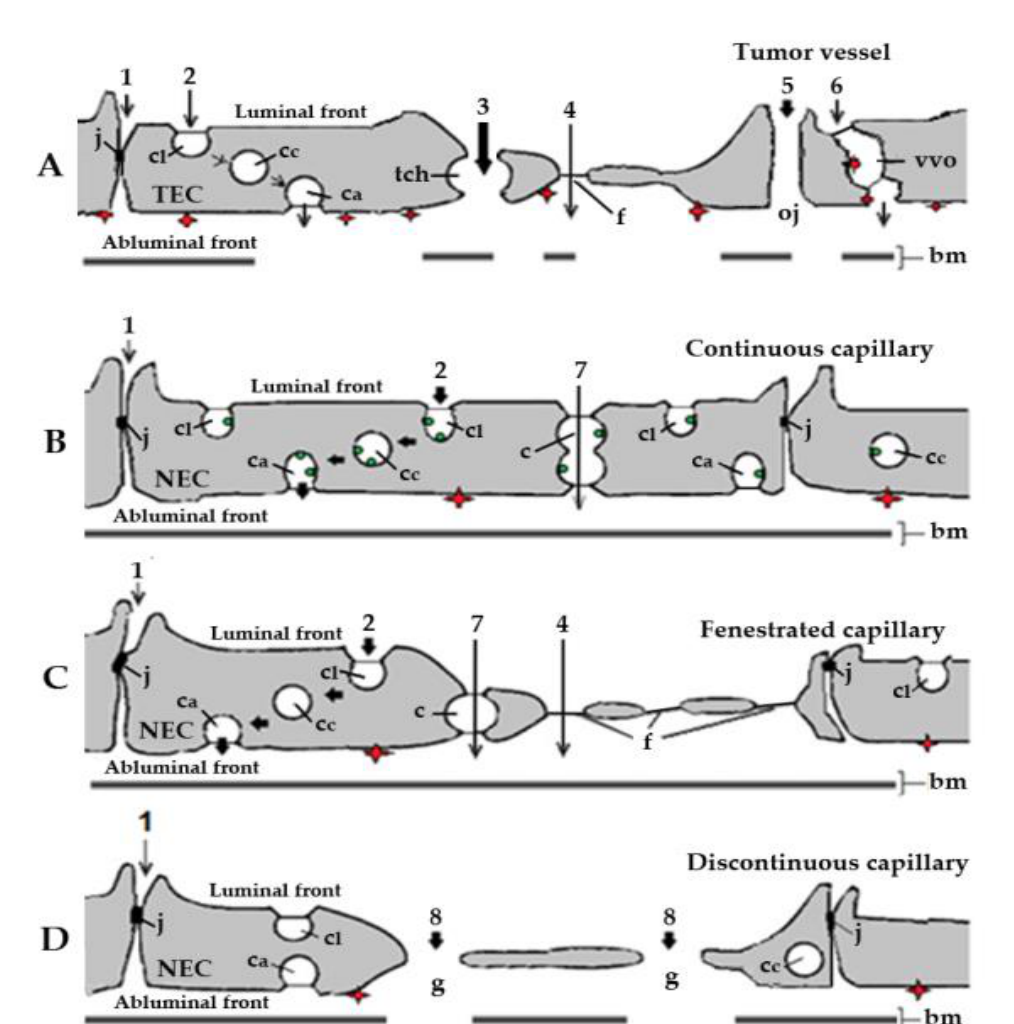
Figure 1. Schematic representation of the basic types of blood capillaries in cancer and healthy organs and tissues. Organelles and routes potentially involved in the transendothelial transport of small molecule receptor tyrosine kinase inhibitors (RTKIs) bound to plasma albumin. ( A ). Tumor capillary. Effective and efficient transport of RTKI-albumin conjugates by diffusion via large transendothelial channels (tch, pathway 3) and open junctions (pathway 5) towards interstitial space of cancer tissues. By contrast, the actual participation of tight junctions (pathway 1), caveolae (pathway 2), fenestrae (pathway 4), and vesiculo-vacuolar organelles (pathway 6) in the transport of anti-angiogenic agents from plasma to the subendothelial space in tumors should be very limited. ( B ). Continuous capillary. Caveolar transport (pathway 2)—possibly the main transport mechanism of RTKIs bound to albumin mediated by albumin-binding proteins (ABPs) in continuous capillary endothelia of normal organs and tissues (e.g., skeletal and cardiac muscles, in fat tissue, connective tissue, arterial capillaries of the lung, and in the skin). ( C ). Fenestrated capillary. Caveolar fluid phase transport (pathway 2; possibly the main transport mechanism of RTKI-albumin conjugates and anti-angiogenic antibodies in fenestrated capillary endothelia of normal organs and tissues). The transport through the diaphragmed fenestrae (pathway 4) should make a minor contribution to the transport of anti-angiogenics due to their negative charges (e.g., fenestrated capillaries in healthy kidney, digestive tract mucosa, and all endocrine glands). ( D ). Discontinuous capillary. Diffusion through the endothelial gaps (pathway 8; effective and efficient transport but only in liver, spleen, and bone marrow), highly dependent on the concentration of both RTKIs and anti-angiogenic antibodies in blood. The red diamonds represent the angiogenic receptor tyrosine kinases (RTKs) exposed on the abluminal (tissue) front of capillary endothelia. In tumor capillaries, the angiogenic RTKs (the targets of anti-angiogenic agents) are overexpressed. The green dots represent albumin-binding sites (ABPs) associated with caveolae in healthy continuous capillaries. bm, basal membrane; c, channel; c a , abluminal caveolae; c c , cytoplasmic caveolae; c l , luminal caveolae; f, fenestra; g, gap; j, junction; NEC, normal endothelial cell; tch, large transendothelial channel; oj, open junction; TEC, tumor endothelial cell. Adapted with permission from ref. [41]. Copyright 1995 Journal of